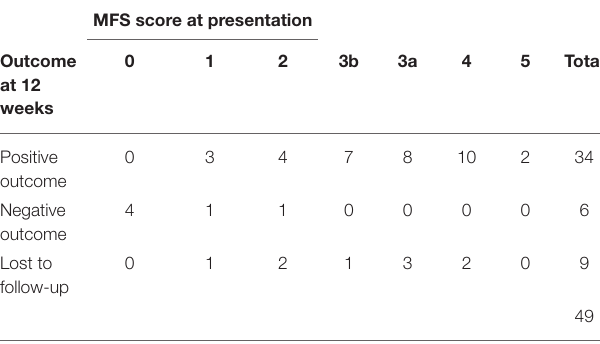
TABLE 4 | Outcome at 12 weeks by Modified Frankel Score (MFS) score at presentation. MFS score at